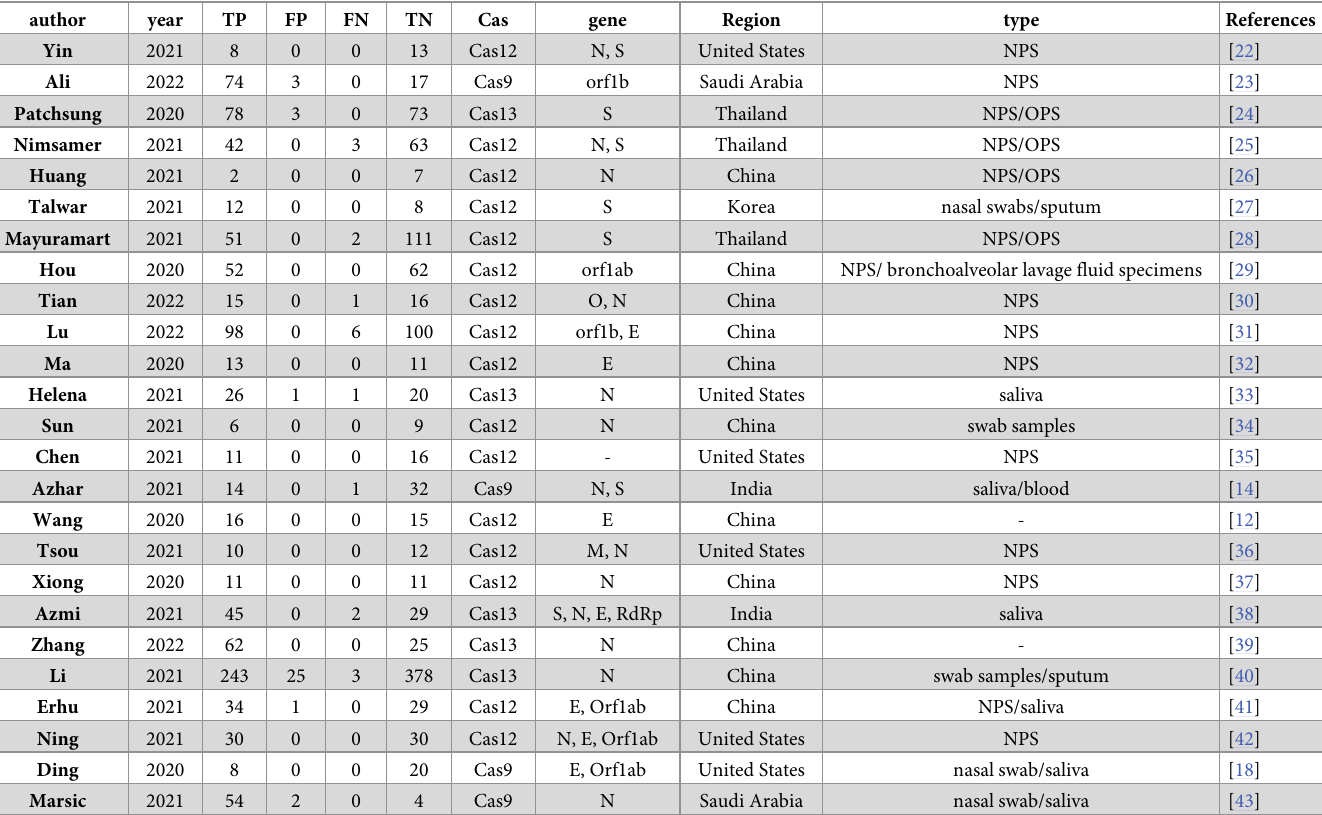
Table 2. Major characteristics of included